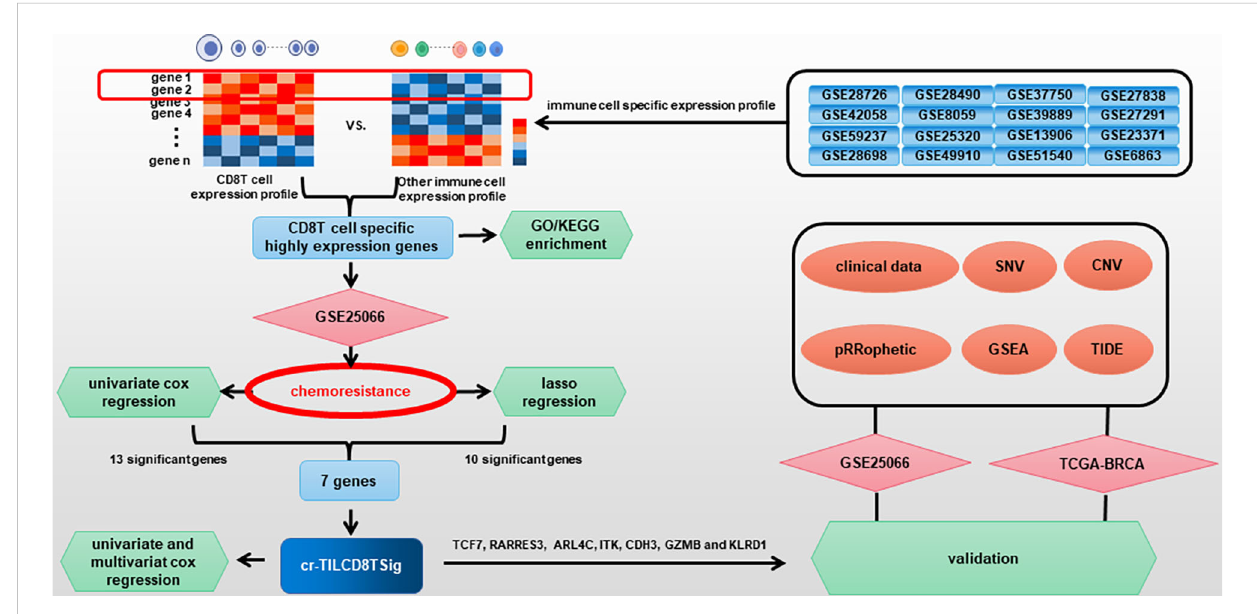
FIGURE 1 Flow diagram for comprehensive characterization of cr-TILCD8TSig subgroups in breast